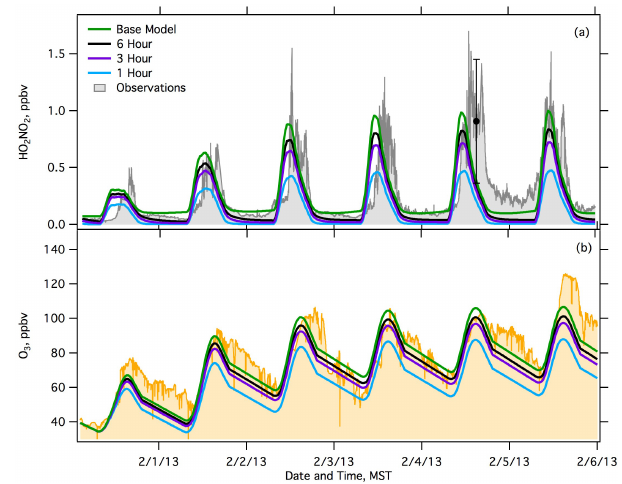
Figure 6. Comparison of PNA and ozone observations throughout an ozone formation event observed during UBWOS 2013 and cor- responding model predictions using an explicit chemical box model describing the chemistry. Panel (a) , HO 2 NO 2 observations com- pared to model results applying various PNA lifetimes with respect to deposition ( t PNA ) . The datum shown with error bars, black cir- cle, represents the approximated 60% error on the 2013 HO 2 NO 2 I − CIMS measurements. Panel (b) illustrates the effect varying de- position rates of PNA has on total predicted ozone